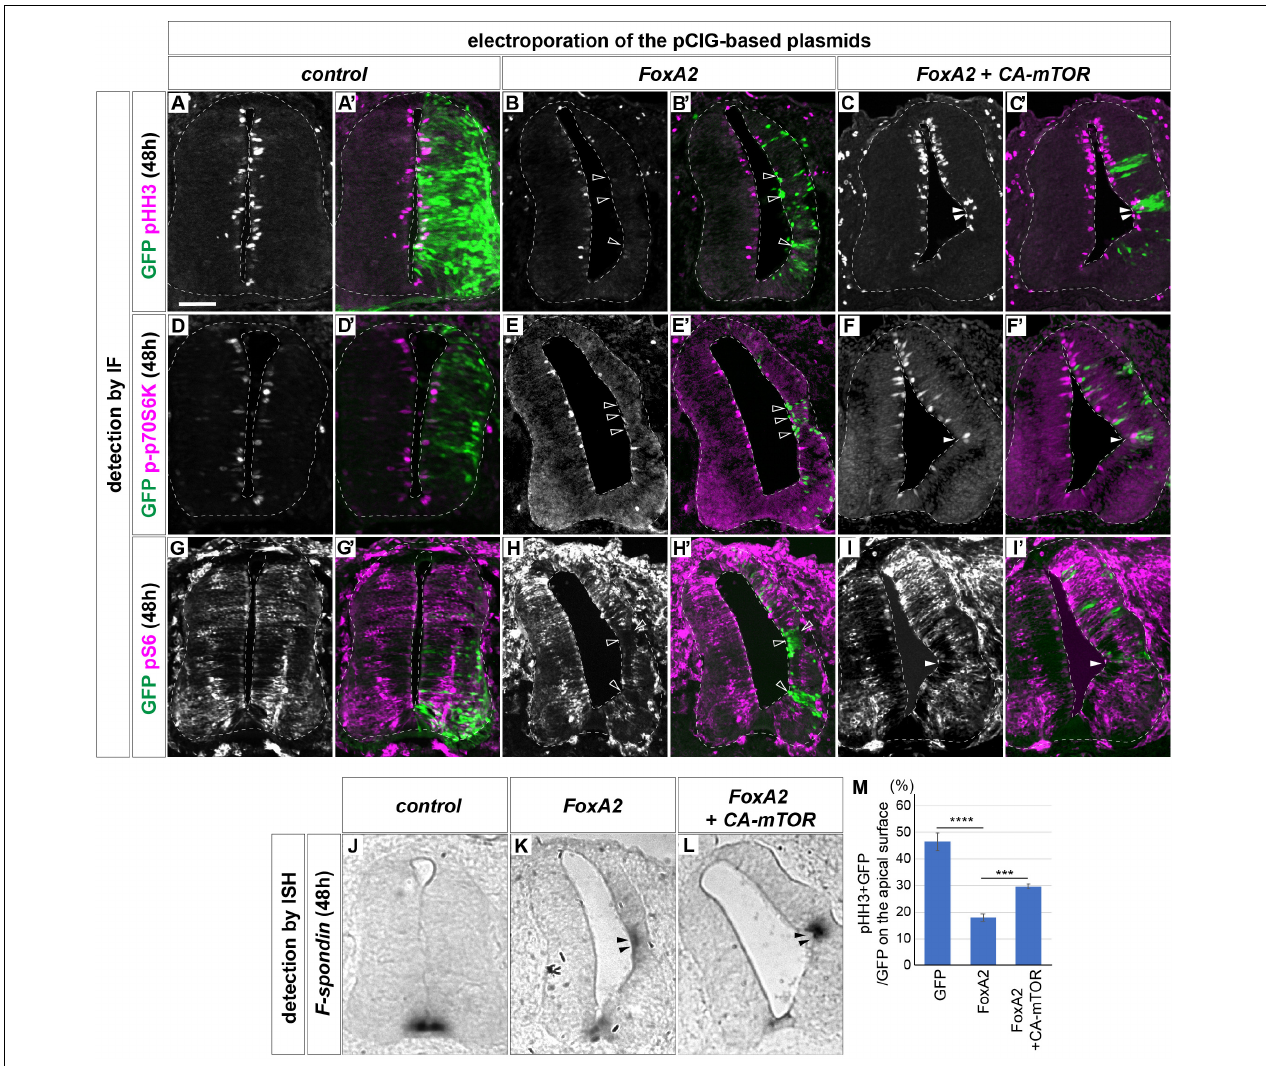
FIGURE 3 | FoxA2 negatively regulates the cell proliferation by blocking the mTOR signal. FoxA2 blocks phosphorylation of p70S6K and S6, and proliferation of the cells without inducing programmed cell death. Plasmids expressing control GFP (A,A’,D,D’,G,G’,J) , FoxA2 (B,B’,E,E’,H,H’,K) or FoxA2 together with CA-mTOR (C,C’,F,F’,I,I’,L) were electroporated into one side of the neural tube of HH stage 12 embryos and the phenotypes were analyzed at 48 hpt by immunofluorescence with pHH3 (A–C’) , p-p70S6K (D–F’) , pS6 (G–I’) , and GFP (A’–L’) antibodies. The merged cells of pHH3 (C,C’) , p-70S6K (F,F’) , or pS6 (I,I’) with GFP expression are indicated by filled arrowheads, and the pHH3- (B,B’) , p-p70S6K- (E,E’) , and pS6- (H,H’) negative on GFP-positive cells are indicated by outlined arrowheads. (J–L) The cell fate determination for FP by FoxA2 is not altered by CA-mTOR. F-spondin -positive cells were identified by in situ hybridization. The F-spondin expression ectopically induced by FoxA2 is indicated by filled arrowheads (K,L) . Analysis in (J–L) were performed on the adjacent sections of (G–I) , respectively. (M) Quantitative data for (A–C’) . Scale bar = 50 µ m. ∗∗∗ p < 0.001, ∗∗∗∗ p <